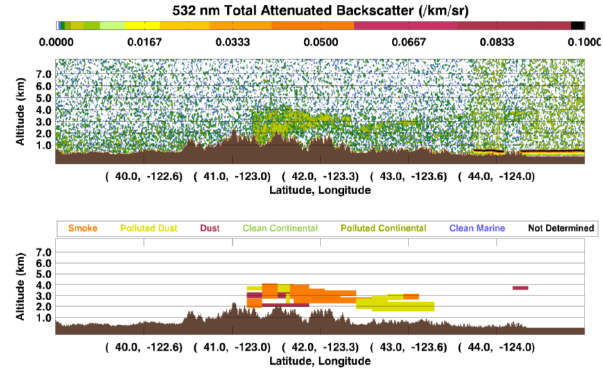
Figure 3. Example of profiles for Level-1 CALIOP 532nm total attenuated backscatter data product (top) and the matching Level- 2 product of aerosol layers (bottom) for the 28 August 2006 over the Klamath Mountains in California and Oregon. The presence of aerosols classified as biomass burning smoke can be seen. Image from Raffuse et al.